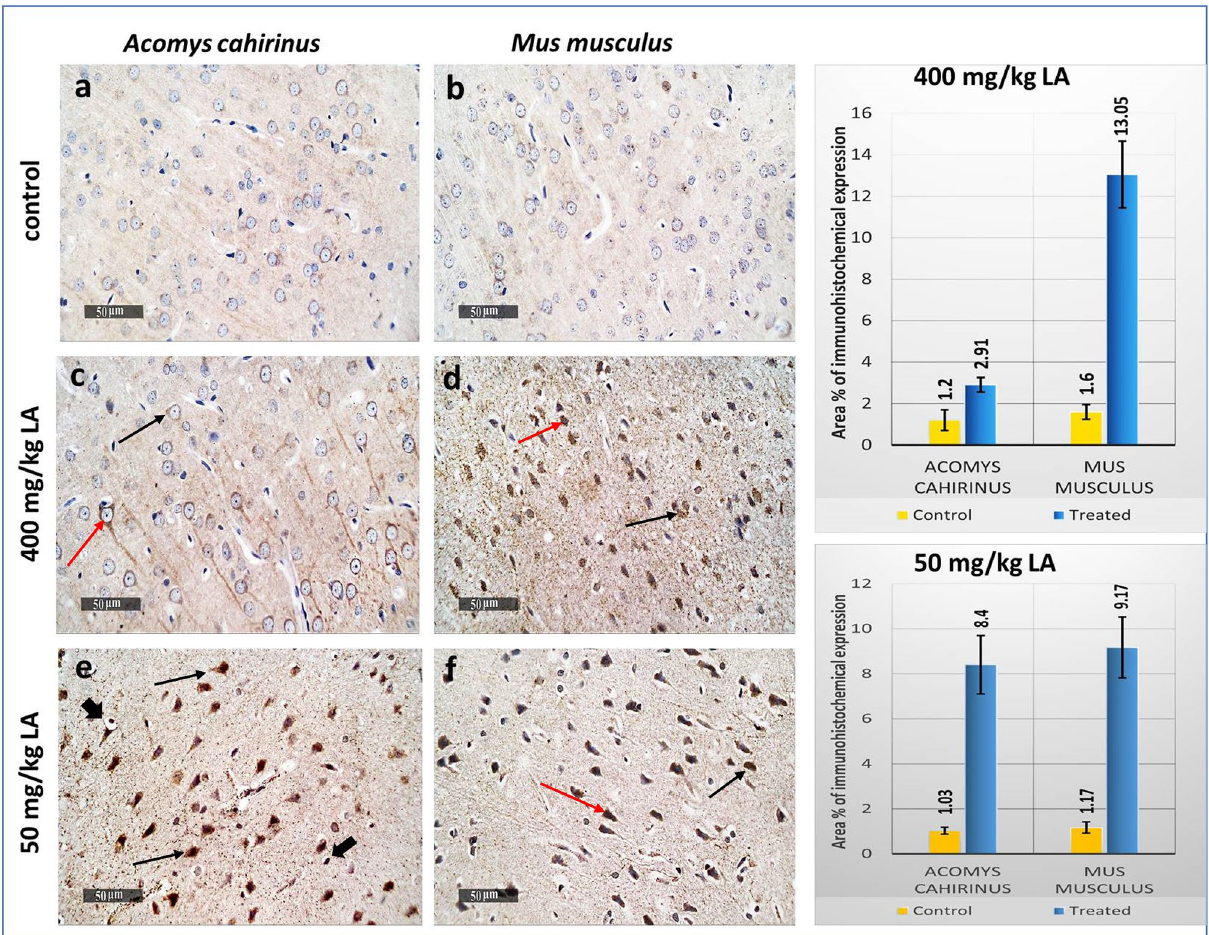
Figure 7. Photomicrographs represent immunohistochemistry staining of TNF alpha is evident in outer granular neurons (black arrow) and outer pyramidal neurons (red arrow) with co-existence in associated glial cells (arrowhead). ( a ) Normal control brain cortex of Acomys . ( b ) Normal control brain cortex of Mus . ( c,d ) Brain cortex sections of (400 mg/kg LA) treated Acomys and Mus respectively. ( e,f ) Brain cortex sections of Acomys and Mus treated with (50 mg/kg LA) for five consecutive